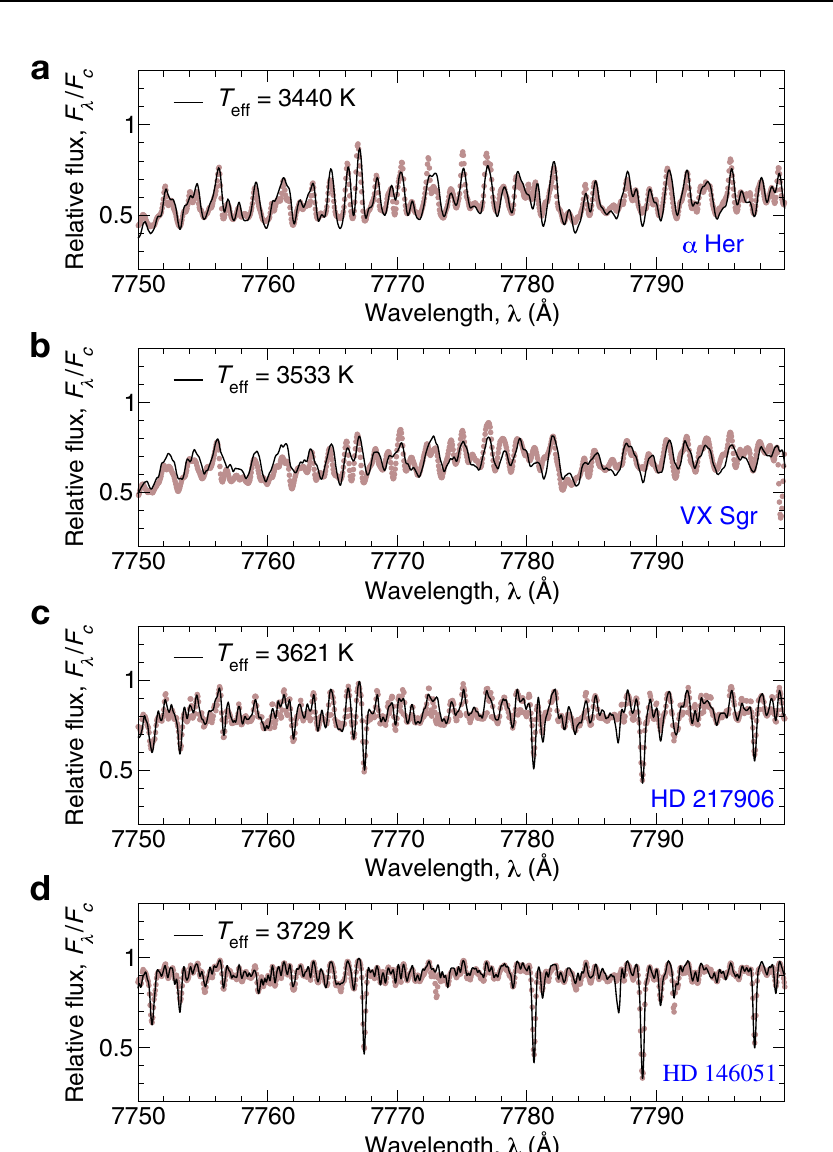
Fig. 8 The best fi ts of the parts of spectra of Betelgeuse in 7750 – 7800 Å range for four represented supergiant stars. Relative fl ux is calculated as a ratio of the fl ux at a particular wavelength ( F λ ) to the fl ux in continuum ( F c ). The solid black line is a theoretical pro fi le calculated with the particular T eff obtained in this study. The observed spectra are shown by brown dots. The name of the star and its T eff are presented on each panel. a The best- fi t for the coolest star in our sample, α Her, with effective temperature ( T eff ) 3440 K. b The best- fi t for VX Sgr with T eff = 3533 K. c The best- fi t for HD 217906 with T eff = 3621 K. d The best- fi t for HD 146051 with T eff = 3729 K. Source data are provided as a Source Data fi